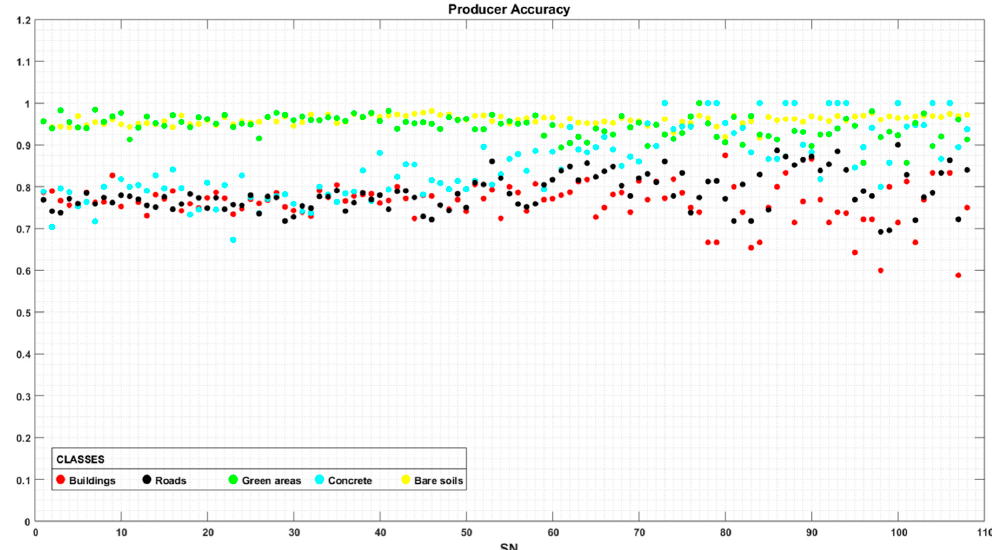
Figure 11. Producer accuracies for each class in classifications based on SSM 3.